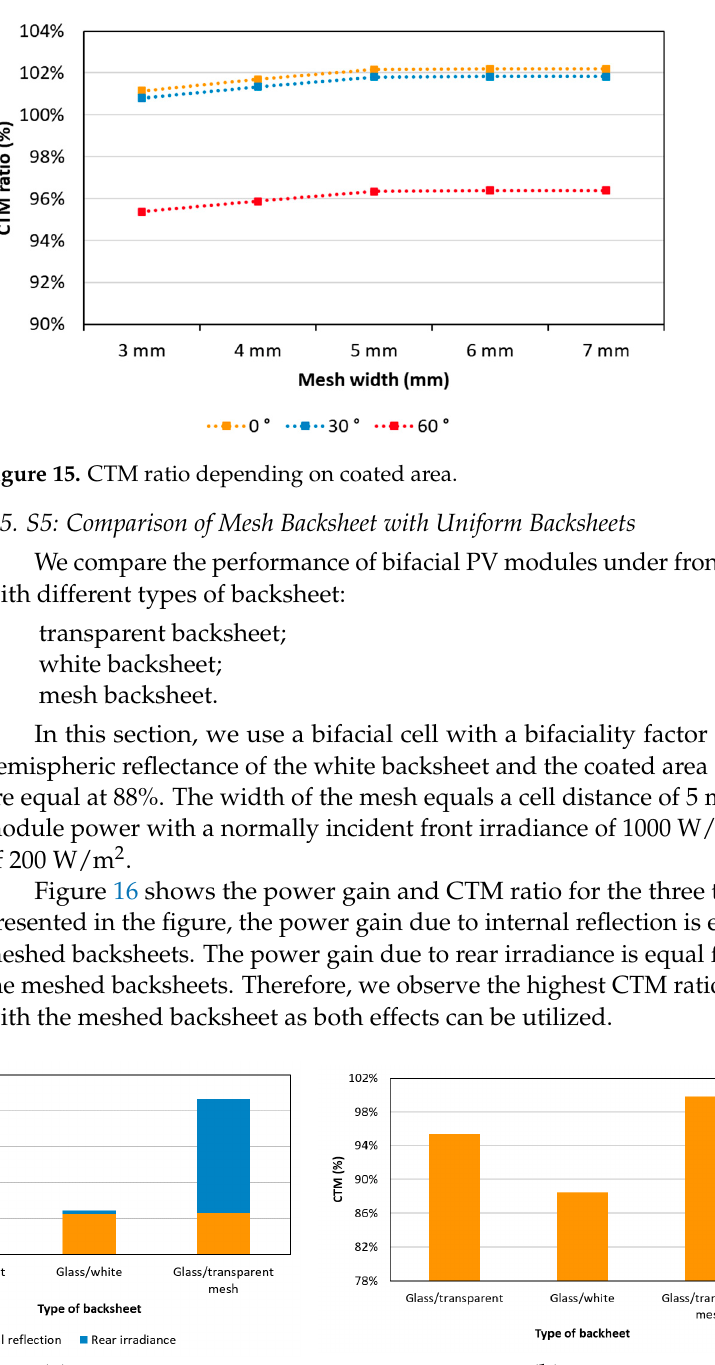
Figure 14. Performance of bifacial PV module with transparent mesh backsheet considering the module operating temperature for different angles of incidence: ( a ) operating temperature; ( b ) power loss due to operating temperature compared to standard test conditions (25 °C).